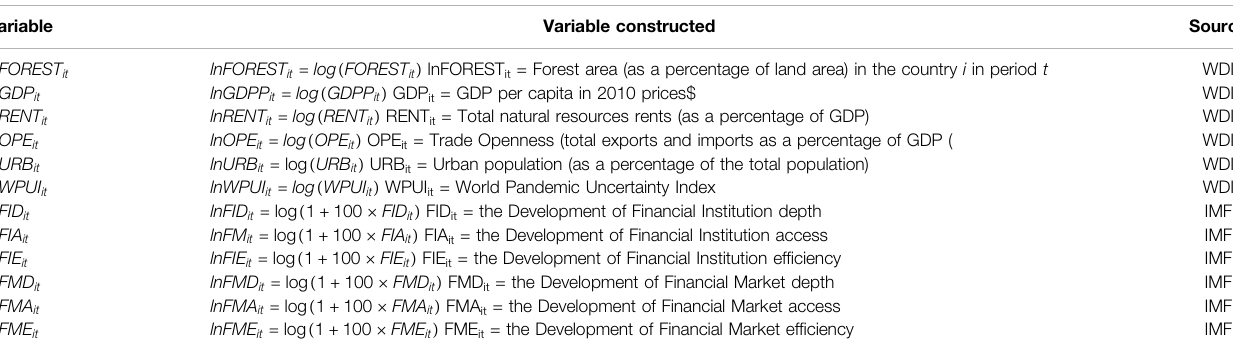
TABLE 1 | Constructed